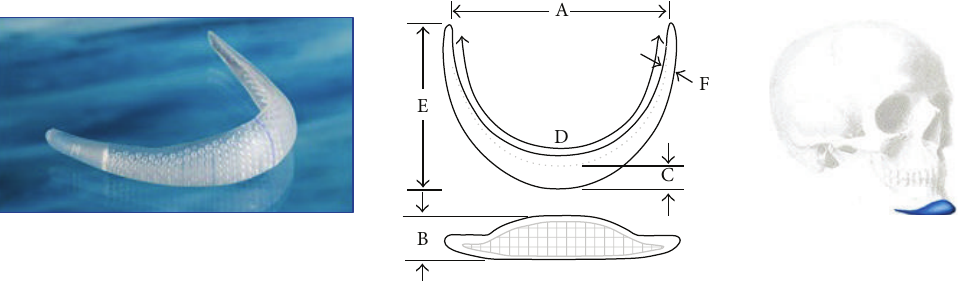
F 4: Implantech Conform extended anatomical chin implant